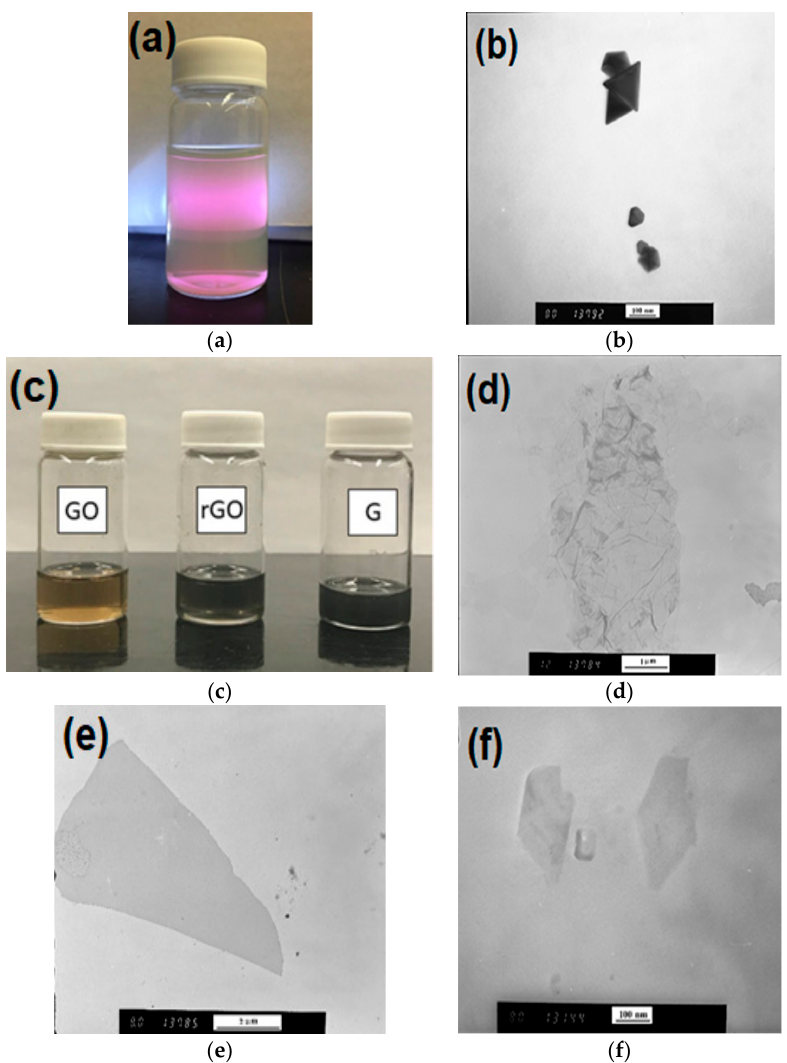
Figure 1. ( a ) Image of the synthesized colloidal silver nanoparticle suspension used for assembling the dendrites. ( b ) TEM image of the corresponding silver nanoparticles (Scale bar: 100 nm). ( c ) Suspensions (0.1 mg/mL) of the graphene-based materials used in this study and corresponding TEM images: ( d ) graphene oxide (GO) dispersed in ethanol (scale bar: 1 μ m); ( e ) reduced graphene oxide (rGO) dispersed in N-Methyl-2-pyrrolidone (NMP) (scale bar: 2 μ m); ( f ) graphene nanoplatelets (GNPs) dispersed in NMP (scale bar: 100 nm).